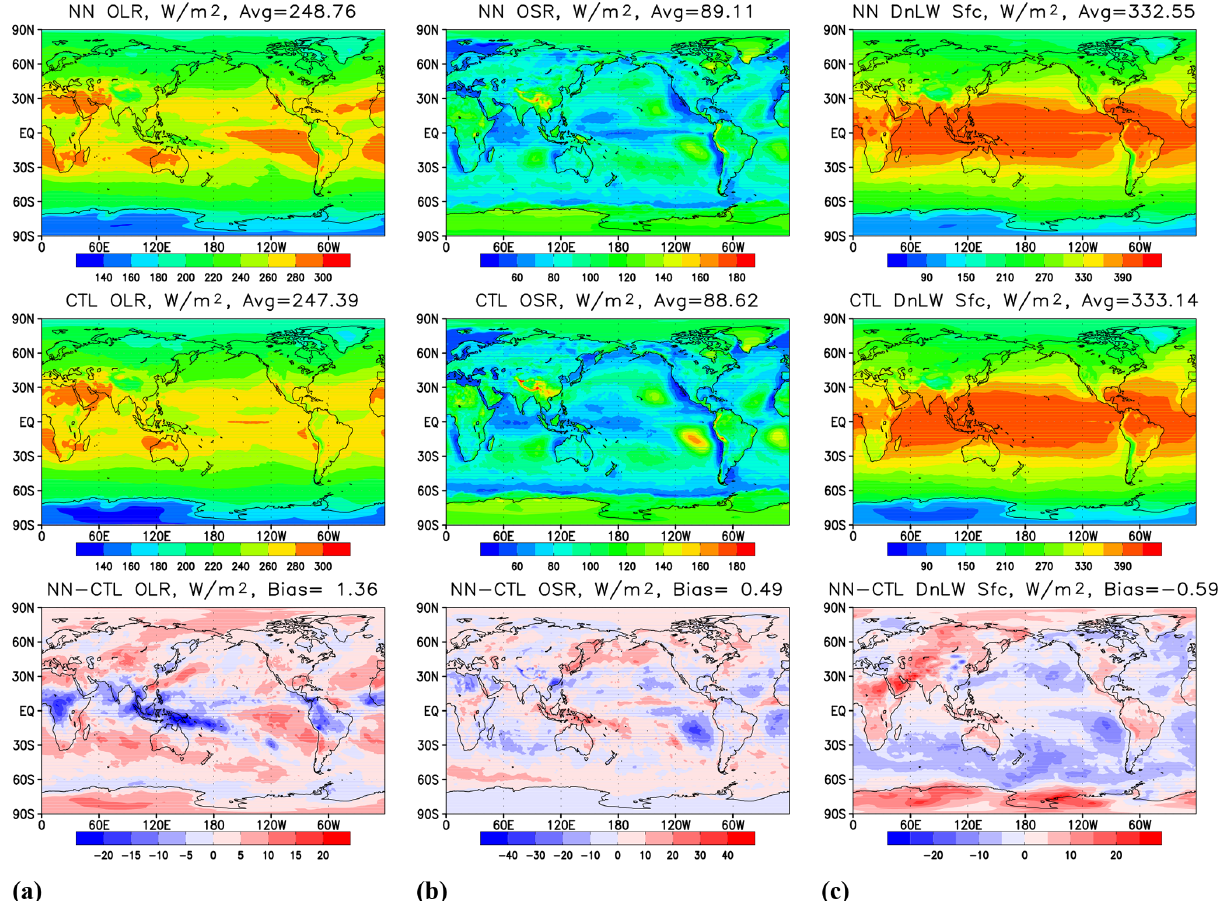
Figure 2. Time mean over 12 months’ worth of model output covering 1 February 2018–1 February 2019 for (a) outgoing LW radiation at the TOA, (b) outgoing SW radiation at the TOA, and (c) downwelling SW radiation at the surface. Upper row – results produced by HGFS; middle – results by GFS; lower row: the difference (HGFS −